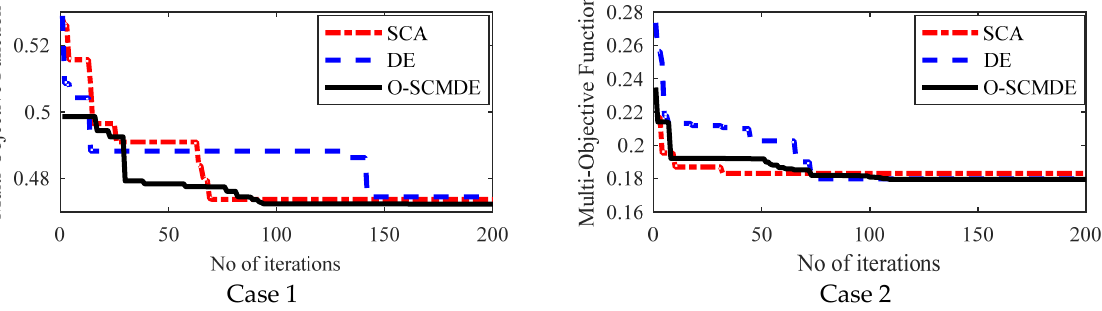
Figure 5. Comparison of the convergence characteristic of the SCA, DEA and O-SCMDEA for both cases of scenario IV of the 33 bus system.